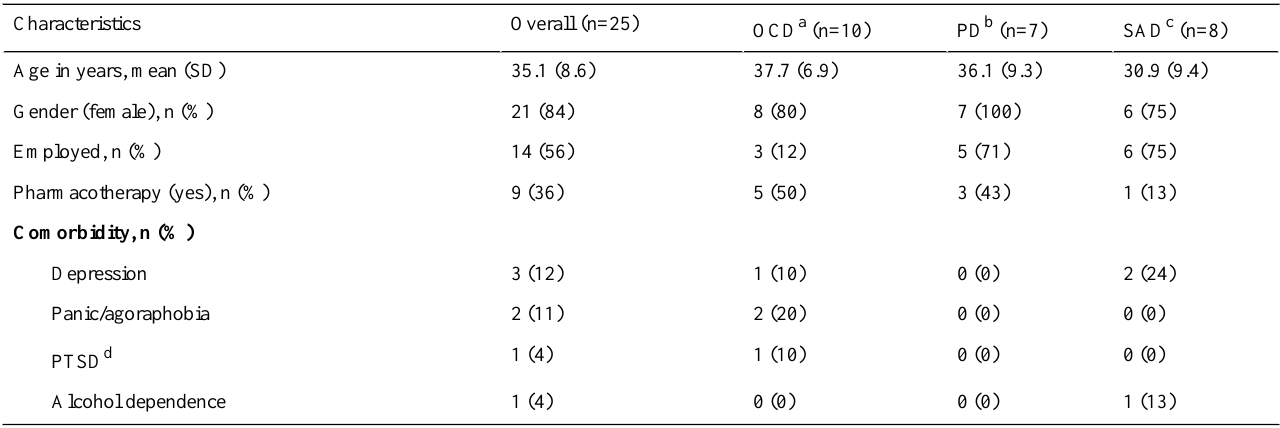
Table 1. Participant clinical and demographic